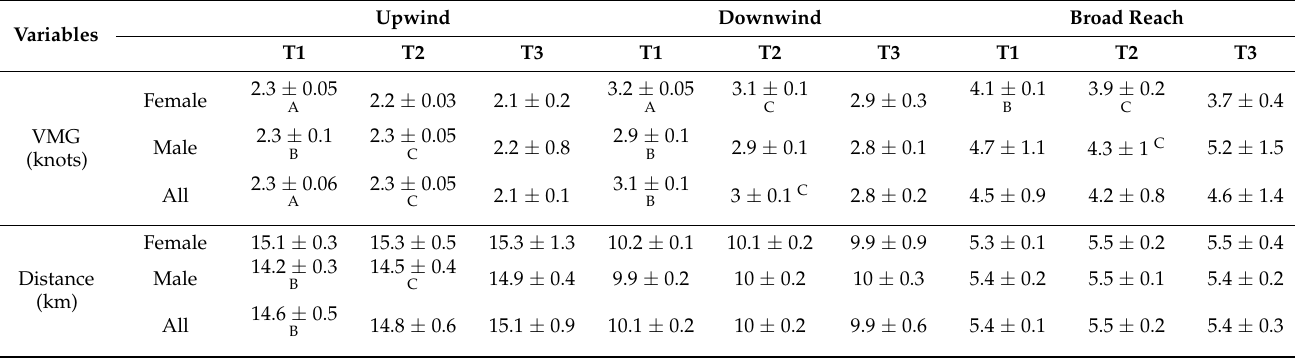
Table 1. Data of mean velocity made good, distance, maneuvers, and time in upwind, downwind, and broad reach in groups of sailors with different performance levels (T1, T2, and T3) in the regatta.